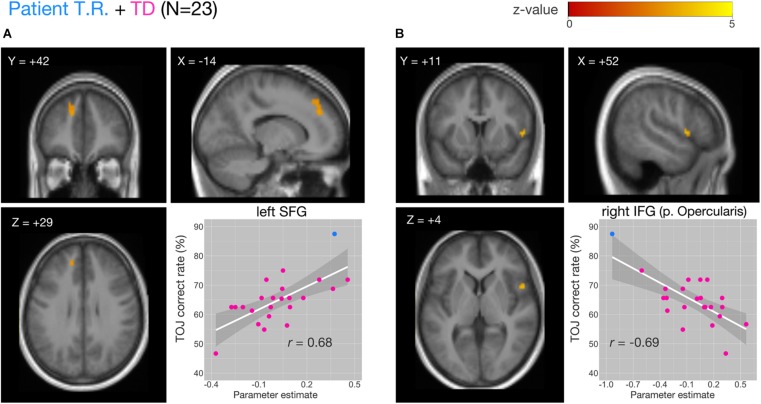
Correlations of functional MRI (fMRI) activation [temporal order judgment (TOJ) > numerosity judgment (NJ)] and correct TOJ performance rates in the left superior frontal gyrus (SFG) and the right inferior frontal gyrus (IFG) after small volume correction (SVC). The analyses were thresholded at voxel level p < 0.001, uncorrected and cluster corrected with pFWE < 0.05. Significant clusters were mapped on sections [x, sagittal; y, coronal; z, axial slices, Montreal Neurological Institute (MNI) coordinates] created from averaged, normalized, T1-weighted images of 23 subjects [the patient T.R. + 22 typically developing (TD) controls]. The correct TOJ rates are plotted against the extracted SPM parameter estimates from the identified clusters in left SFG (A, inset) and right IFG (B, inset) wherein filled circles show individual rates of T.R. (blue) and TD controls (magenta). Shaded regions represent 95% confidence intervals of the Pearson’s correlation coefficients.